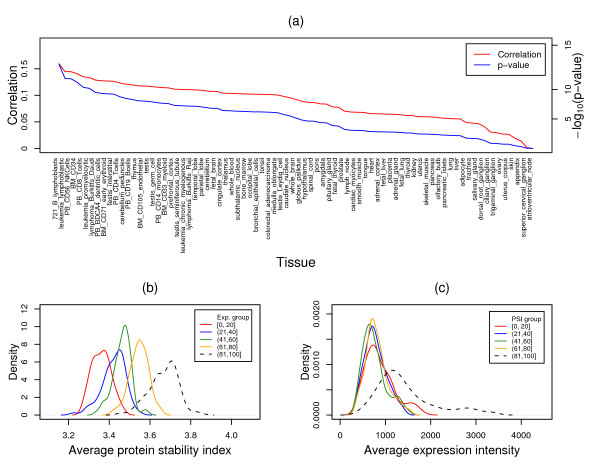
Correlation between gene expression and protein stability. (a) Spearman's rank correlation rho between gene expression from each of the 79 human tissues and protein stability, and corresponding p-values (-log10(p-values)) for the correlation coefficients. (b) Distribution of the average protein stability indices, which were obtained from comparing gene expression in each of the 79 human tissues, for 5 mRNA expression groups with increasing expression values from the group [1,20] to the group (81,100]. (c) Distribution of the average mRNA expression values in the 79 human tissues for 5 protein stability groups with increasing protein stability index from the group [1,20] to the group (81,100]. Exp: mRNA expression; PSI: protein stability. Index.